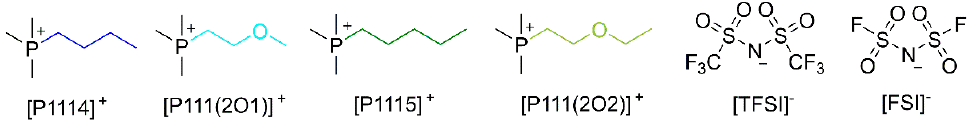
Figure 1. Molecular structures and abbreviation of the ionic liquid phosphonium cations and both anions, namely [TFSI] ‐ and [FSI] ‐ . The numbers correspond to the number of C ‐ atoms in the side chains (1: methyl; 4: butyl; 5: pentyl) or the alkoxy ‐ substituent (2O1: 2 ‐ methoxy ‐ ethyl; 2O2: 2 ‐ ethoxy ‐ ethyl).